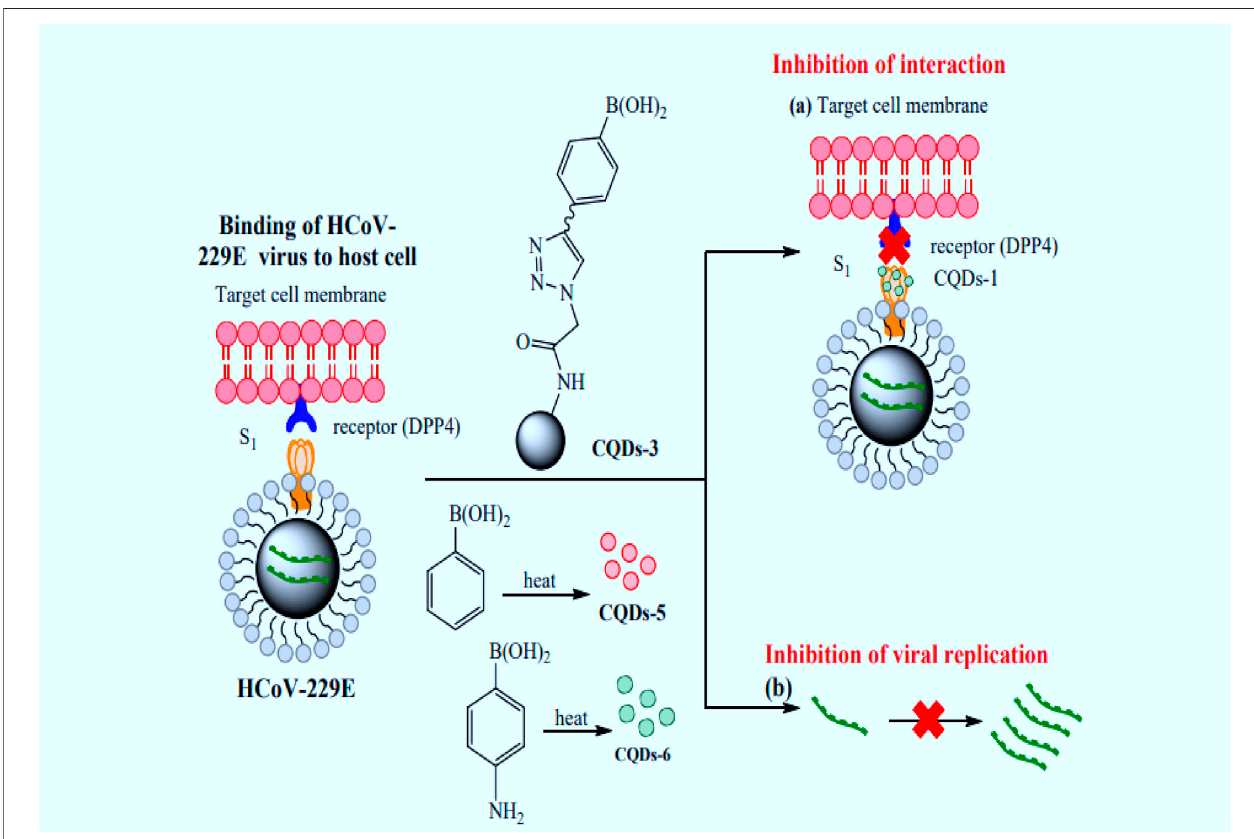
FIGURE 5 | Schematic presentation of the Impact of CQDs, prepared by hydrothermal carbonization, on interaction of HCoV-229E virus and host cells: ( a ) Inhibition of S protein and host receptor interaction. ( b ) Inhibition of HCoV-229E-RNA genome replication. Reprinted and manipulated with the permission of references ( Ł oczechin et al.,